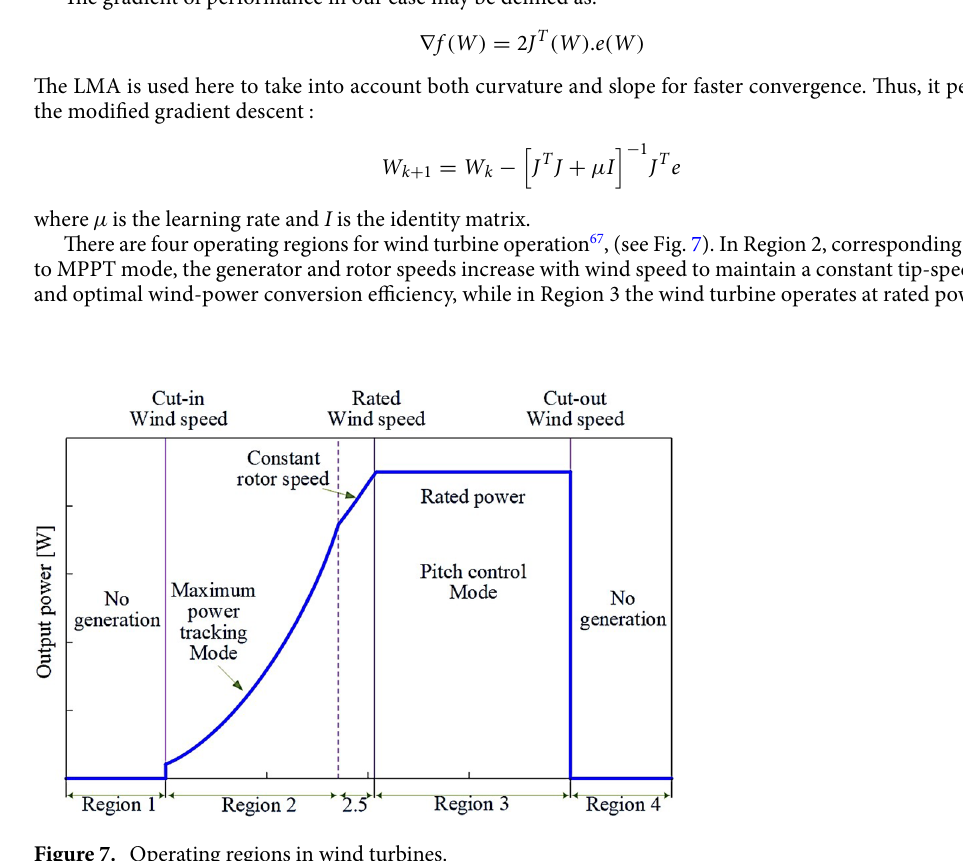
Figure 7. Operating regions in wind